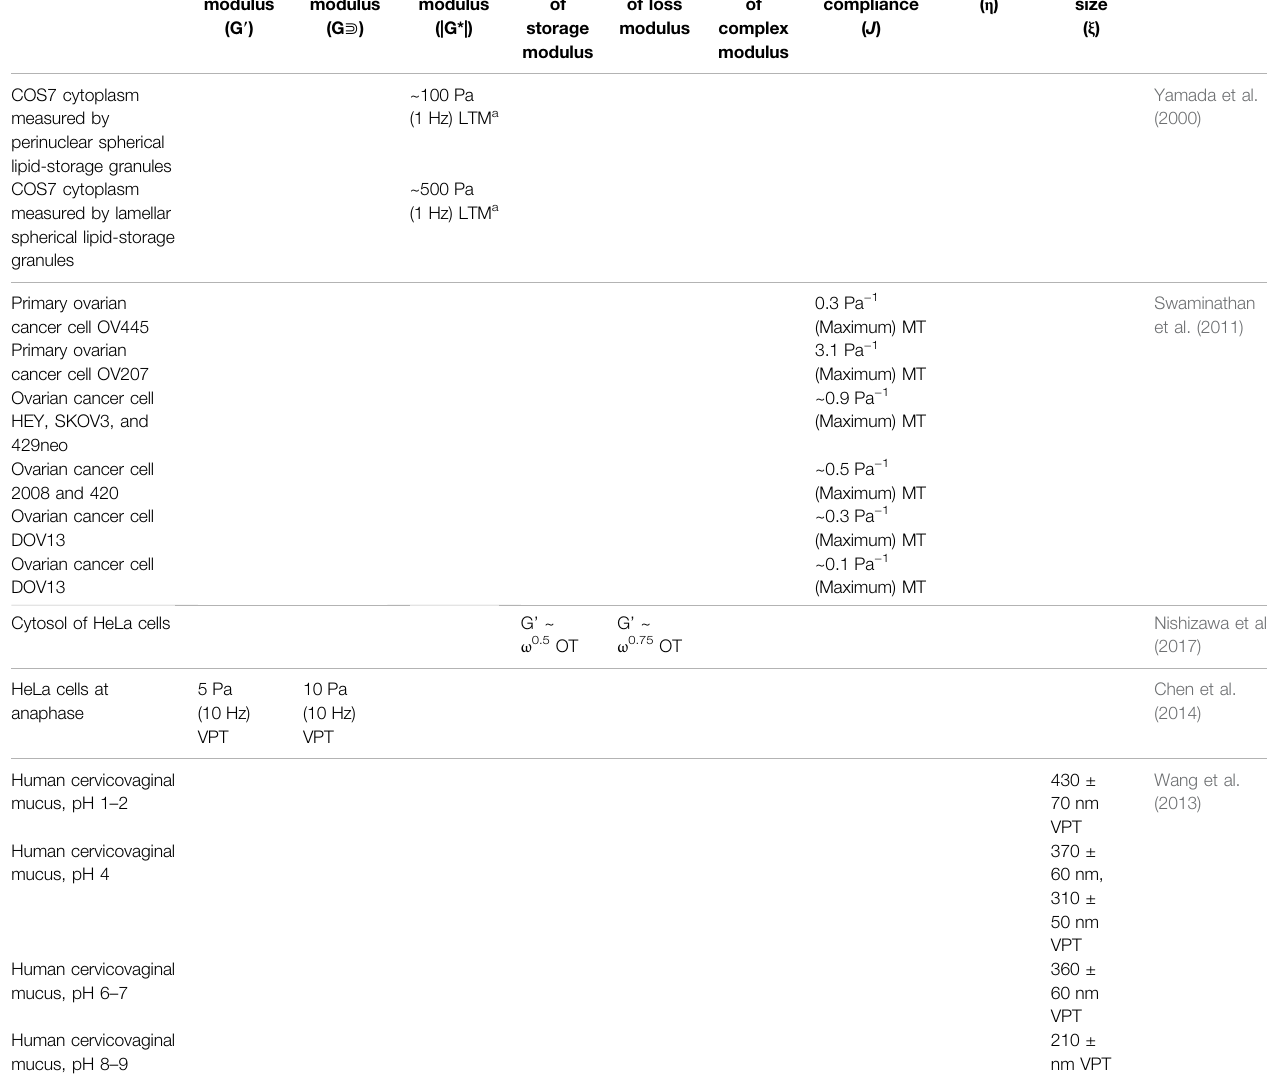
TABLE 7 | Microrheological properties of mammalian cells and bodily fl uids of the urinary and reproductive systems measured by various microrheological techniques.